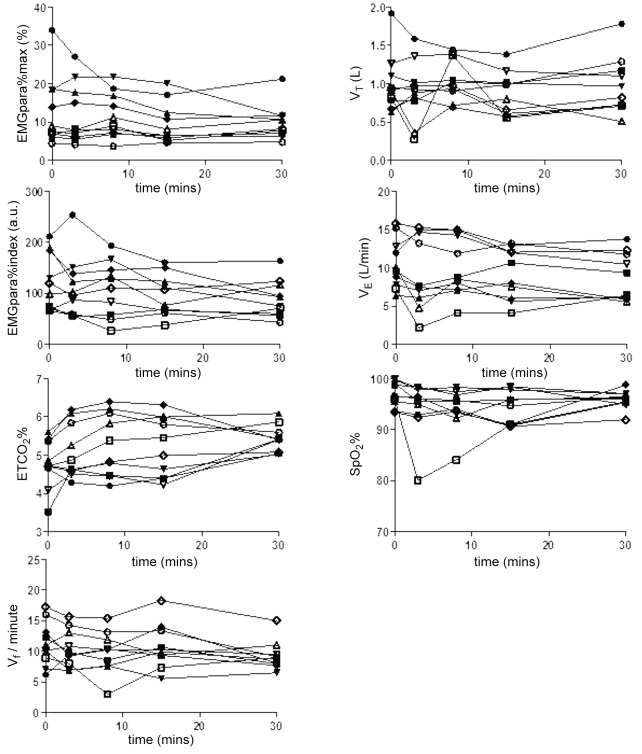
Physiological effects of injectable opioids on individual participants.One-minute averages of physiological data for each of the 10 individuals at baseline (0 minutes) and 3 minutes, 8 minutes, 15 minutes and 30 minutes after injectable opioid administration. VT = tidal volume, VE = minute ventilation, Vf = respiratory rate, SpO2% = oxygen saturation measurement determined by pulse oximetry, ETCO2% = end tidal breath carbon dioxide concentration (%).